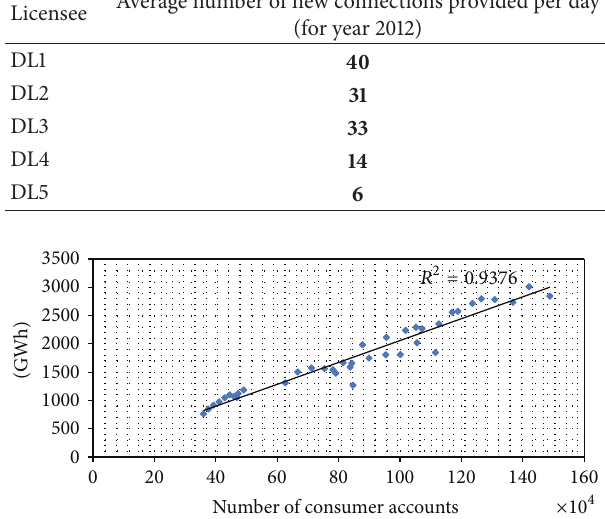
Figure 1: Energy delivered versus the number of consumers.